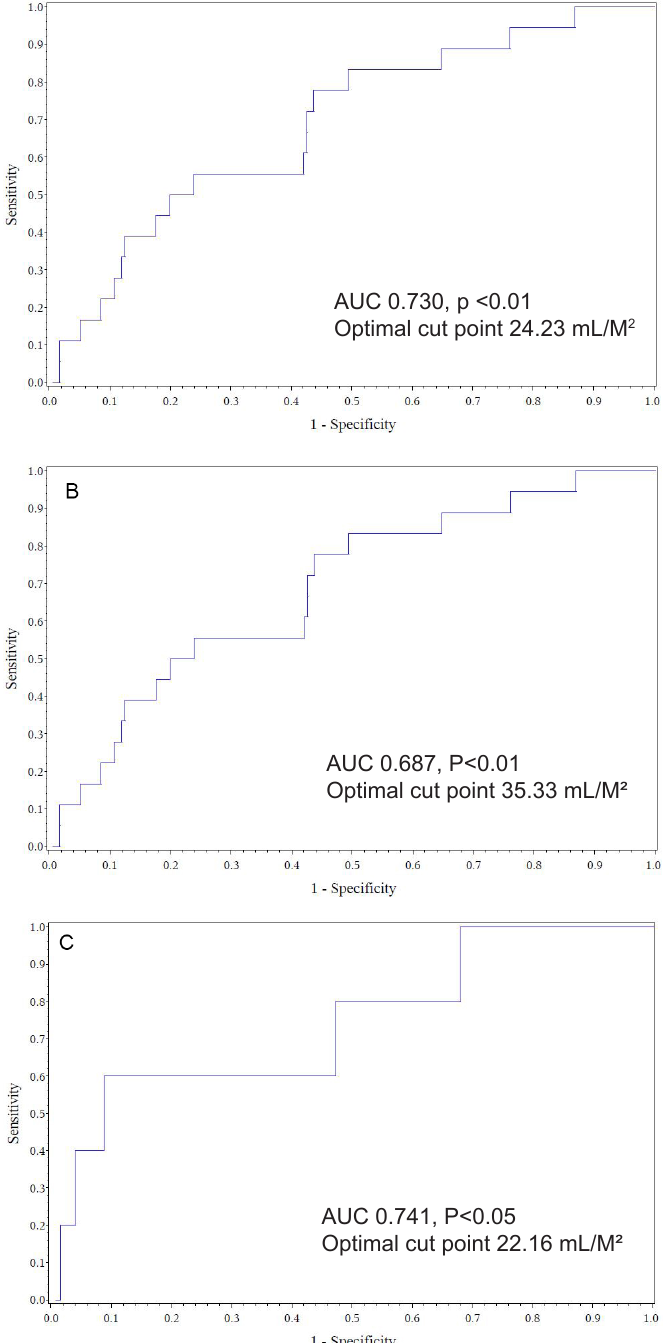
Figure 2. Stroke volume index receiver operating curves for 30- day mortality.